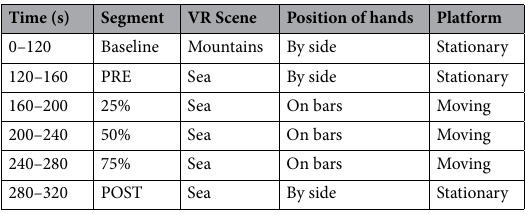
Table 6. Virtual Reality/Platform Synchronization